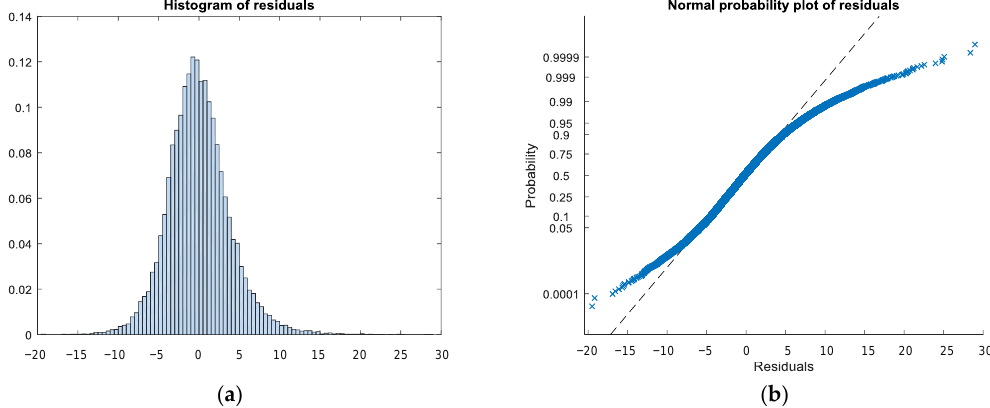
Figure A1. Plot of residuals for the linear model. ( a ) Histogram of residuals; ( b ) Probability plot of residuals.